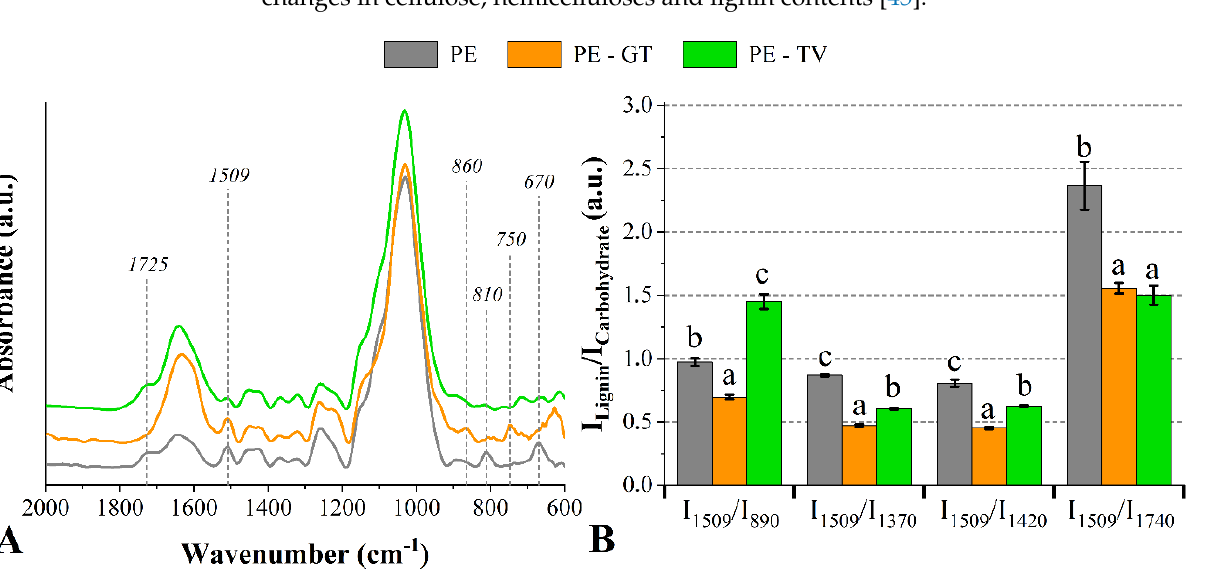
Figure 2. FT − IR spectra ( A ) and lignin/carbohydrate ratios ( B ) of the untreated P. elliottii (P E ) woods exposed to the G. trabeum and T. versicolor fungi. Where: Different letters above the bars indicate statistically different means for each lignin/carbohydrate ratio.